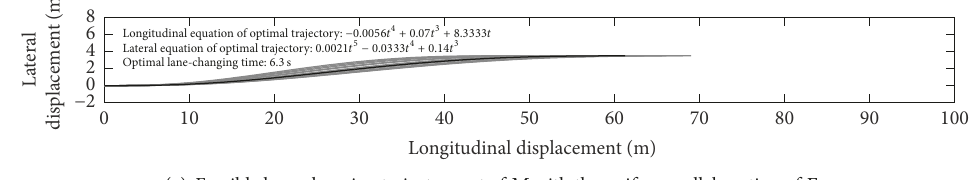
(a) Feasible lane-changing trajectory set of 𝑀 with the uniform collaboration of 𝐹 𝑑